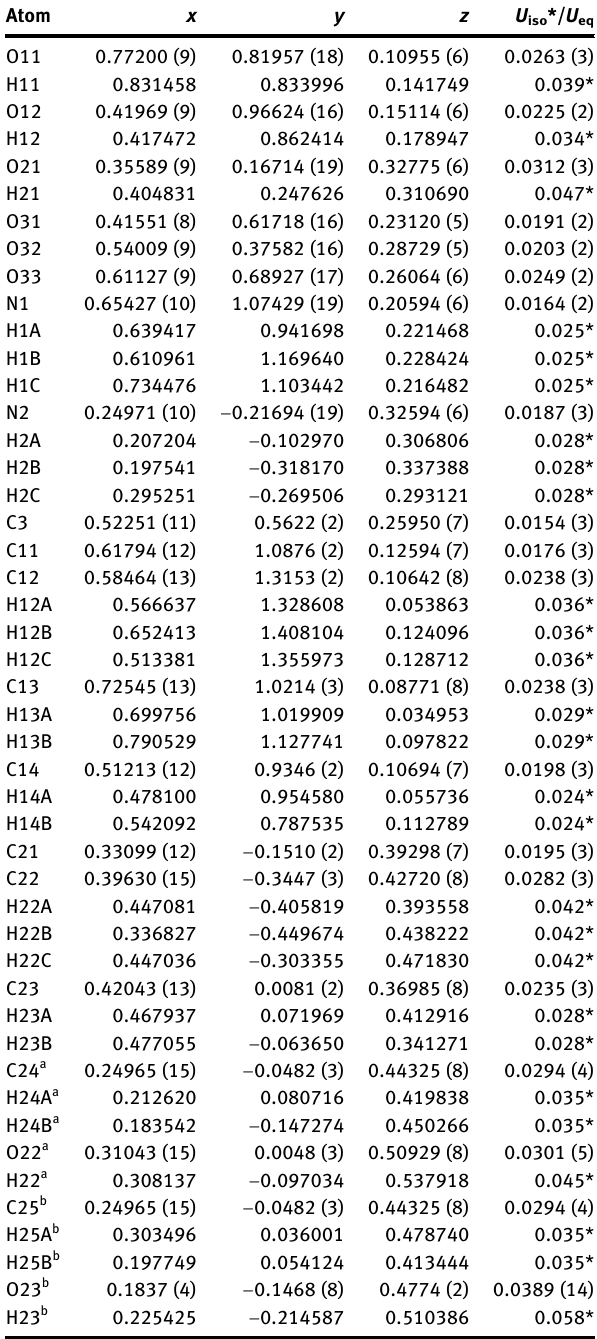
Table  : Fractional atomic coordinates and isotropic or equivalent isotropic displacement parameters (Å 